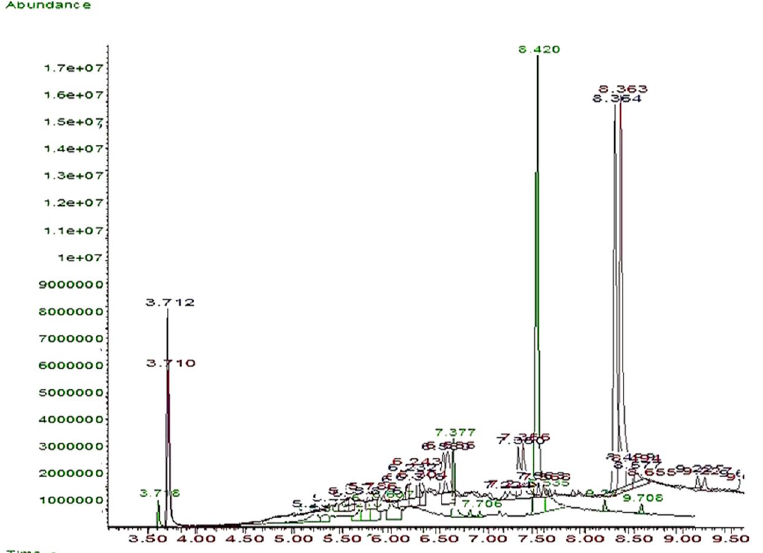
Figure 10. GC-MS Peaks (Aniline concentrations: 150, 200 and 250 mg/L, radiation source: sunlight, pH of the environment: 9, and retention time: 6 hours).